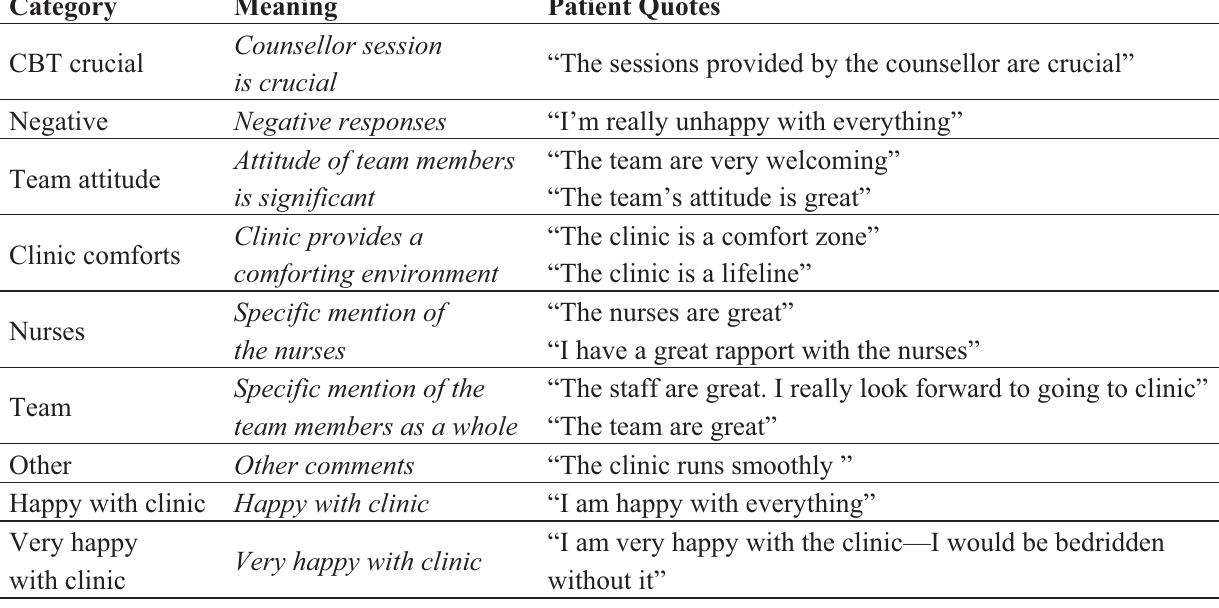
Table 21. Explanation of